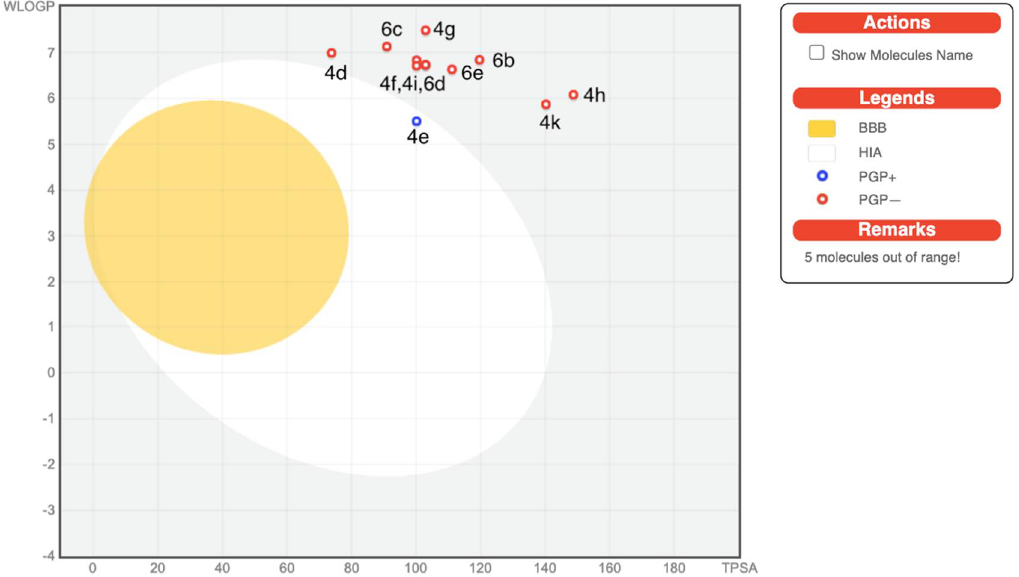
Figure 2. BOILED-Egg diagram of the selected compounds. Table 4. Drug-likeness and toxicity predictions of the selected